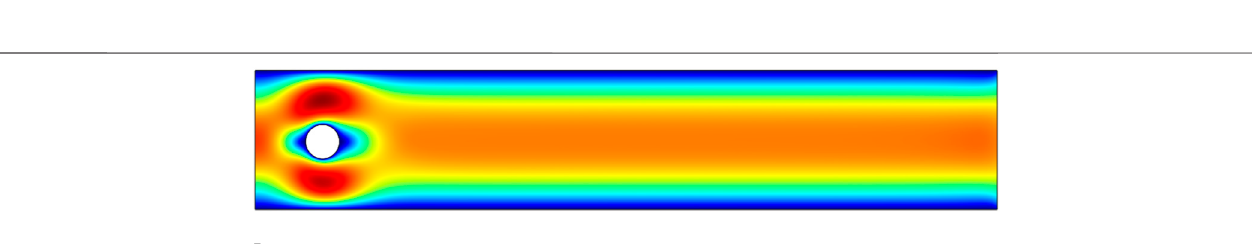
Frontiers in Physics |